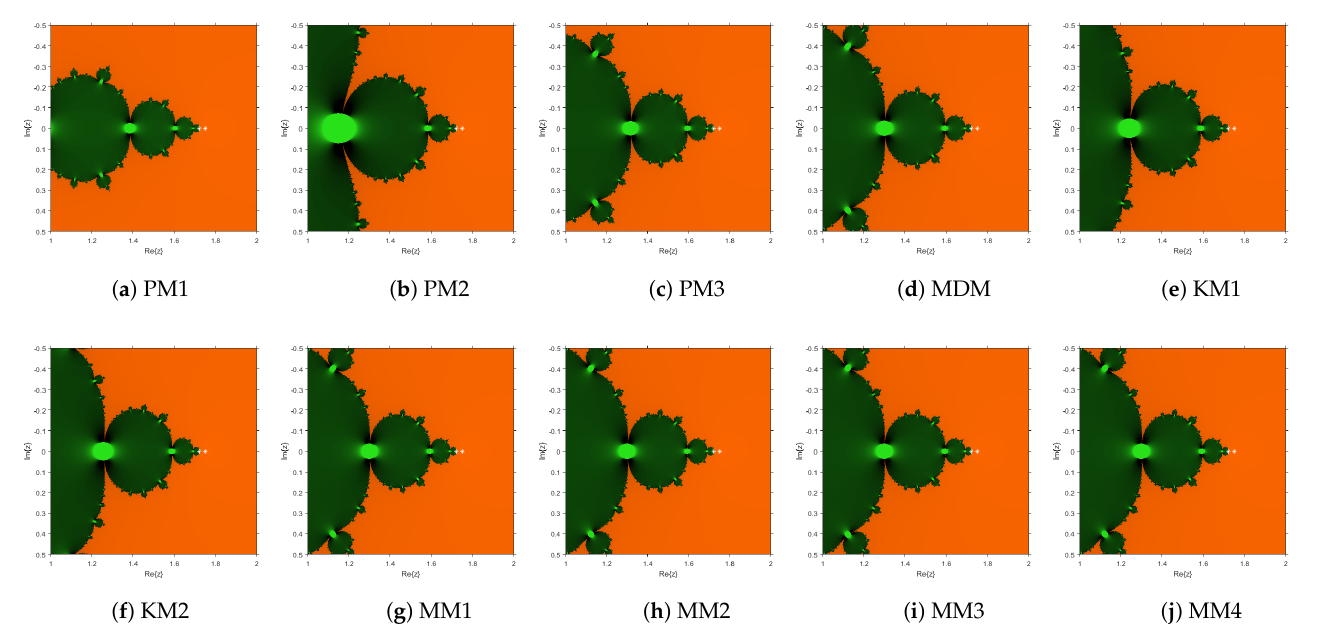
Figure 2. Basins of attraction of new and existing methods for Example